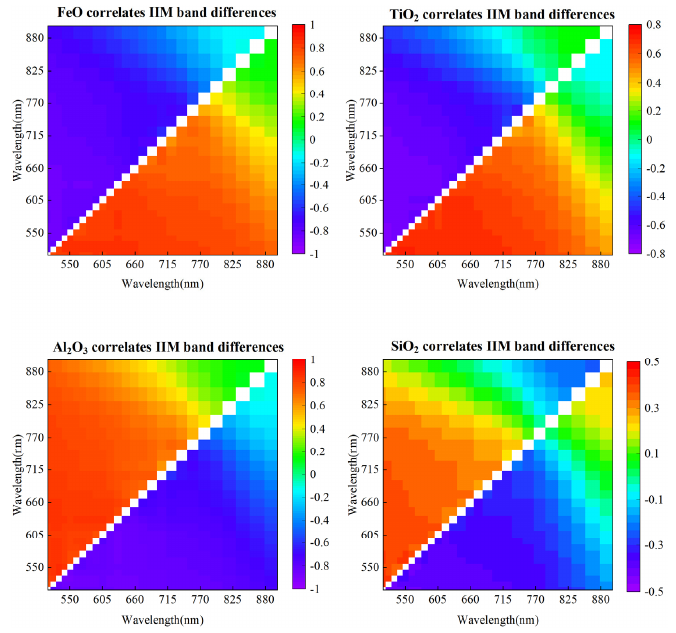
Figure 6. Correlation coefficients between spectral differences and chemical abundances. Each point represents the band difference between the x − and y − axes, and the intensity of each point is the correlation between the band difference and chemical abundance.